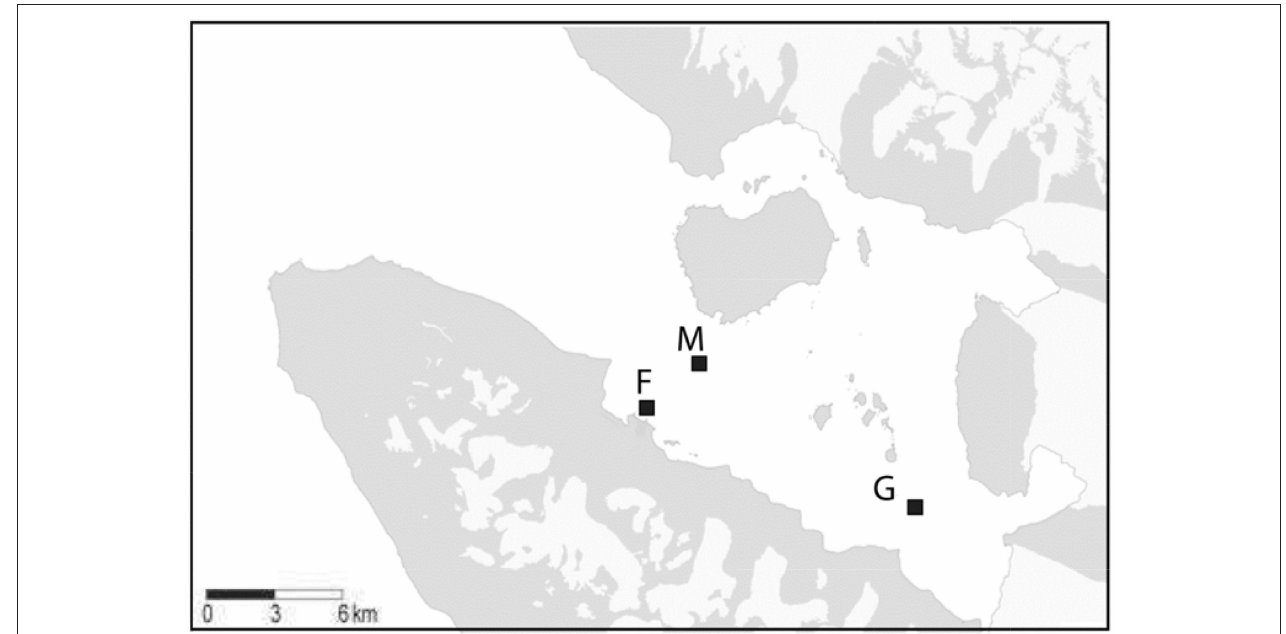
FIGURE 1 | Map of Kongsfjorden with the sampling locations mid fjord: M, glacier: G, ferry box: F. Source: Basisdata/NP_Basiskart_Svalbard_WMS (http://geodata.npolar.no/bruksvilkar/), with stations included as GPS coordinates.